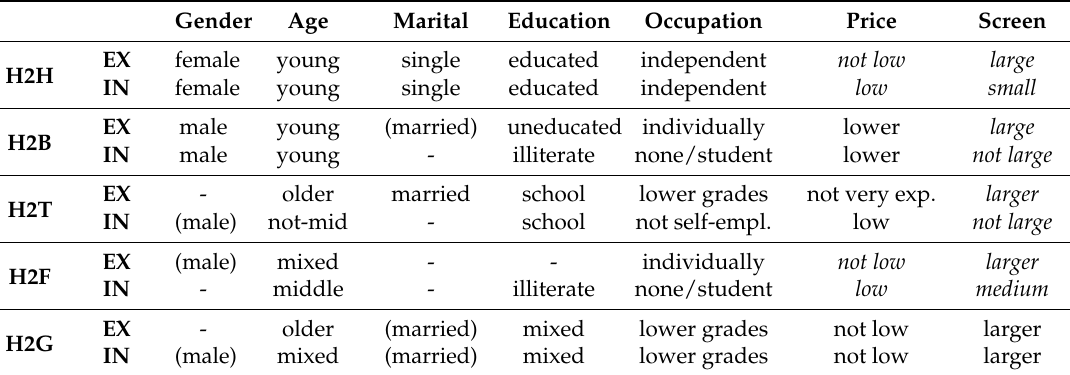
Table 2. Broad characterization of the polymodal media of the mobile phone. Note: Bold/italic: emphasizes differences between ex- and intensity; ( . . . ): weak significance; mixed: non-linear relationship; independent: not-salaried; individually: student + not empl. + self